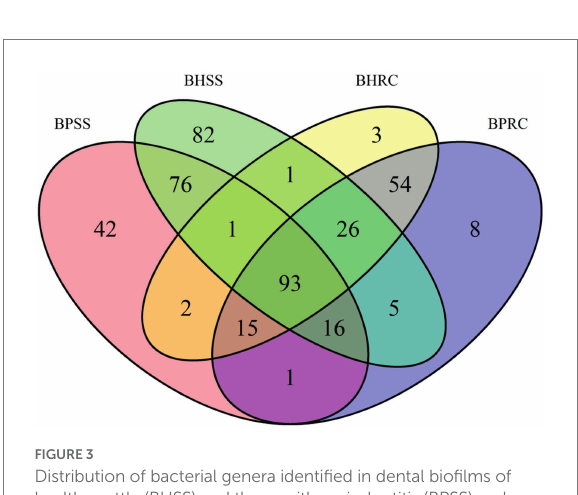
FIGURE 3 Distribution of bacterial genera identified in dental biofilms of healthy cattle (BHSS) and those with periodontitis (BPSS) and ruminal microbiome from bovines with periodontal lesions (BPRC) and clinically healthy bovines (BHRC), represented in the Venn